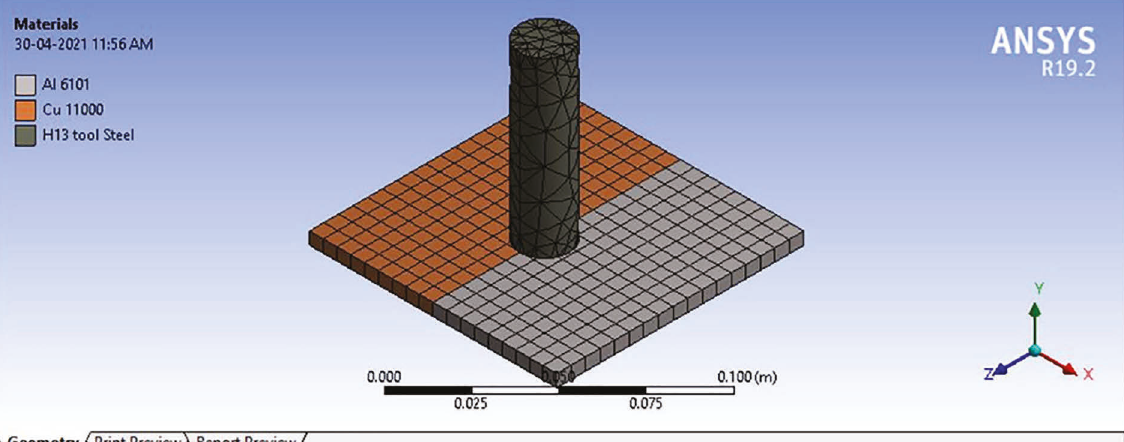
Figure 9: Meshing of geometry tool with base plates.